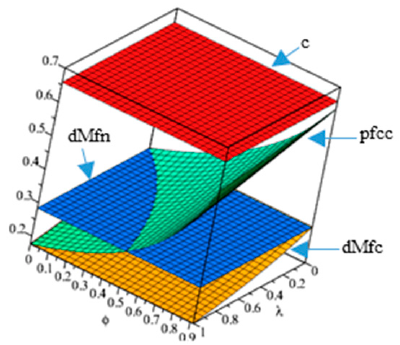
Figure 4. Effects of fairness concerns and profit-sharing on recycling rate.